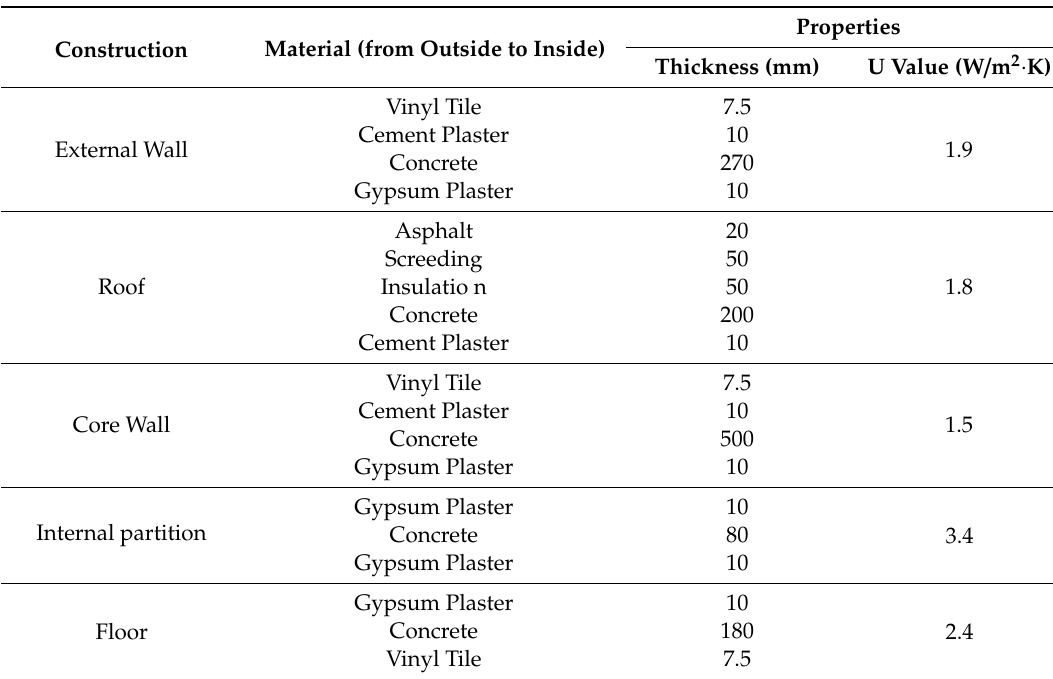
Table 2. Material properties of